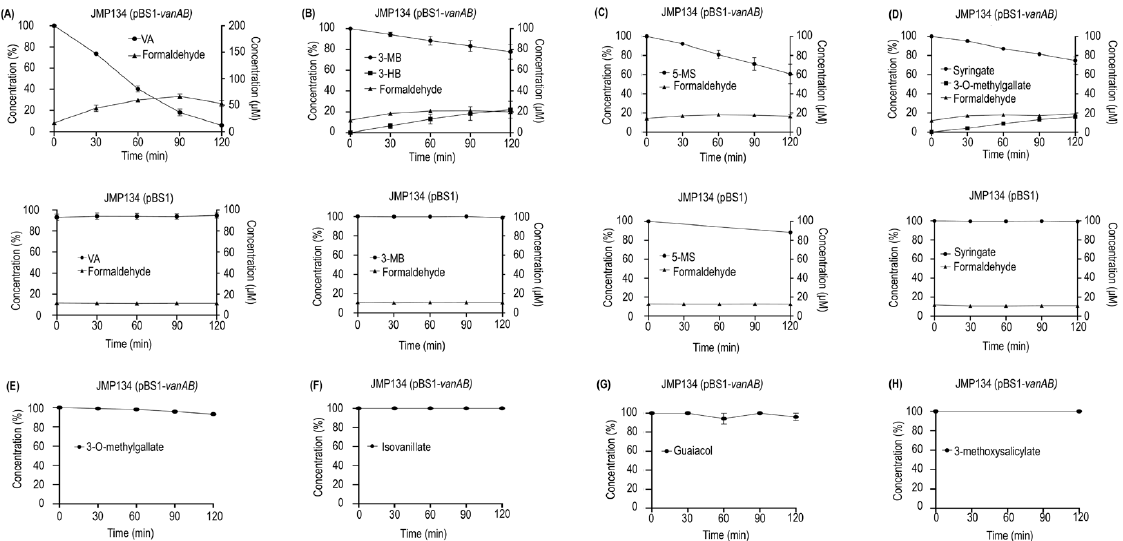
Figure 3. Resting cell assays of Cupriavidus pinatubonensis JMP134 harboring vanAB genes in the presence of compounds structurally related to VA. Cells of C. pinatubonensis JMP134 expressing vanAB genes were grown on 5 mM VA plus 1 mM L-arabinose as inducer, washed, and subsequently exposed to 1 mM ( A ) VA, ( B ) 3-MB, ( C ) 5-MS, ( D ) syringate, ( E ) 3-O-methylgallate, ( F ) isovanillate, ( G ) guaiacol, and ( H ) 3-methoxysalicylate. Cells of C. pinatubonensis JMP134 lacking vanAB genes were grown on 5 mM 3HB plus 1 mM L-arabinose and treated as indicated previously for comparison. Three biological replicates were performed for substrate consumption measurements. Error bars indicate